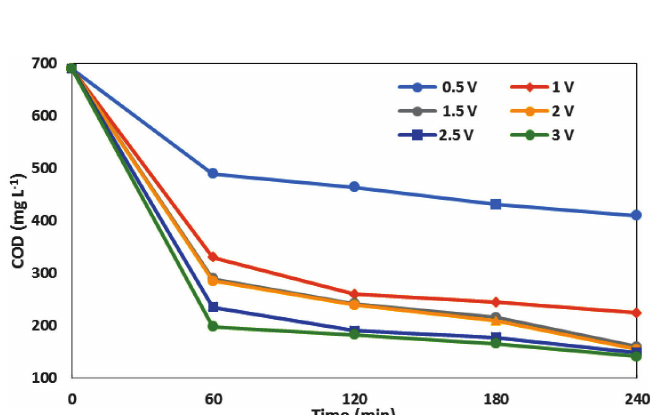
Fig. 2 – Effect of voltage on COD removal of high salinity petrochemical wastewater using PPC (Electrode distance: 2 cm, pH = 4, reaction time: 240 min, uV lamps: 2)